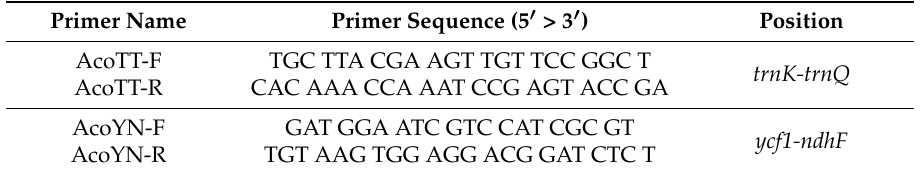
Table 6. Primer information for insertion and selection (indel) marker development in this